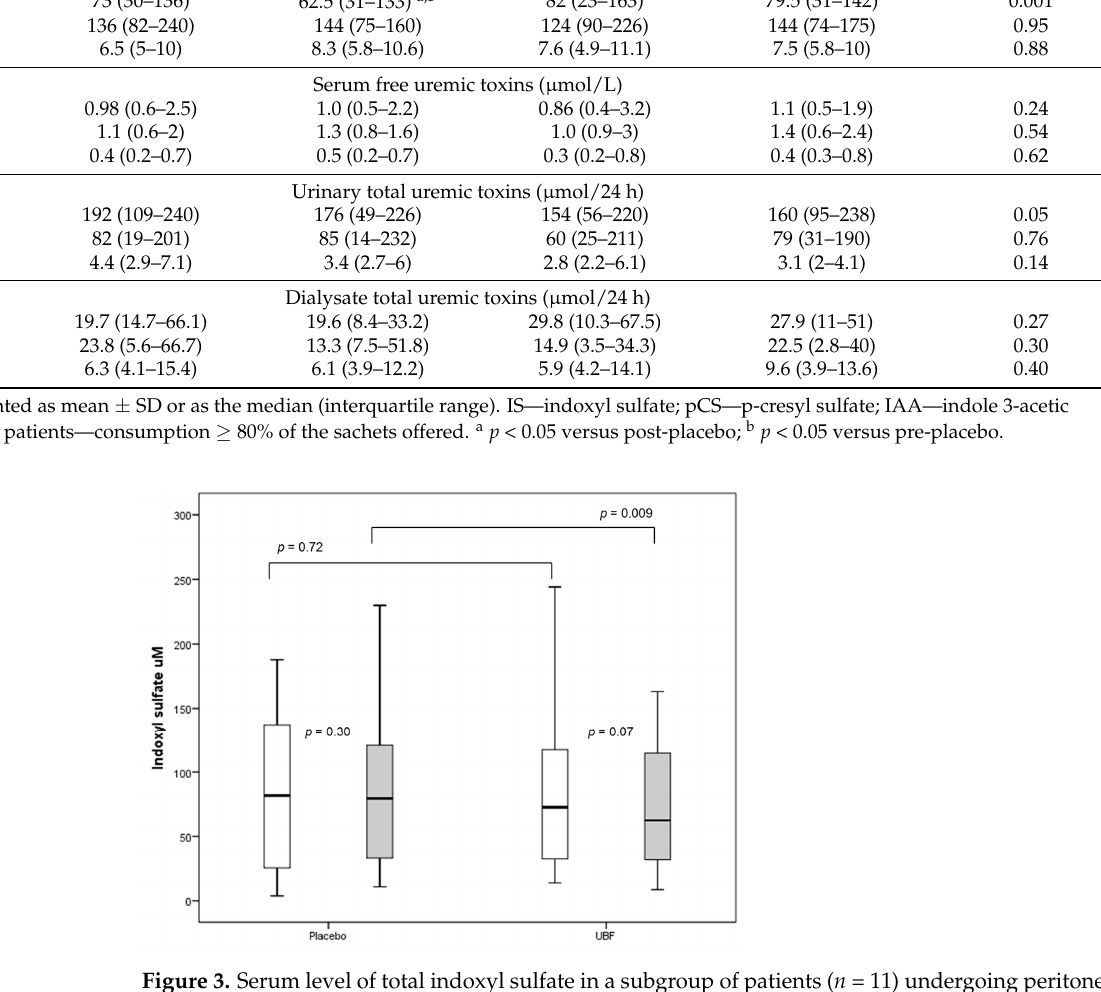
Figure 3. Serum level of total indoxyl sulfate in a subgroup of patients ( n = 11) undergoing peritoneal dialysis pre (white) and post (gray) the use of placebo and UBF.